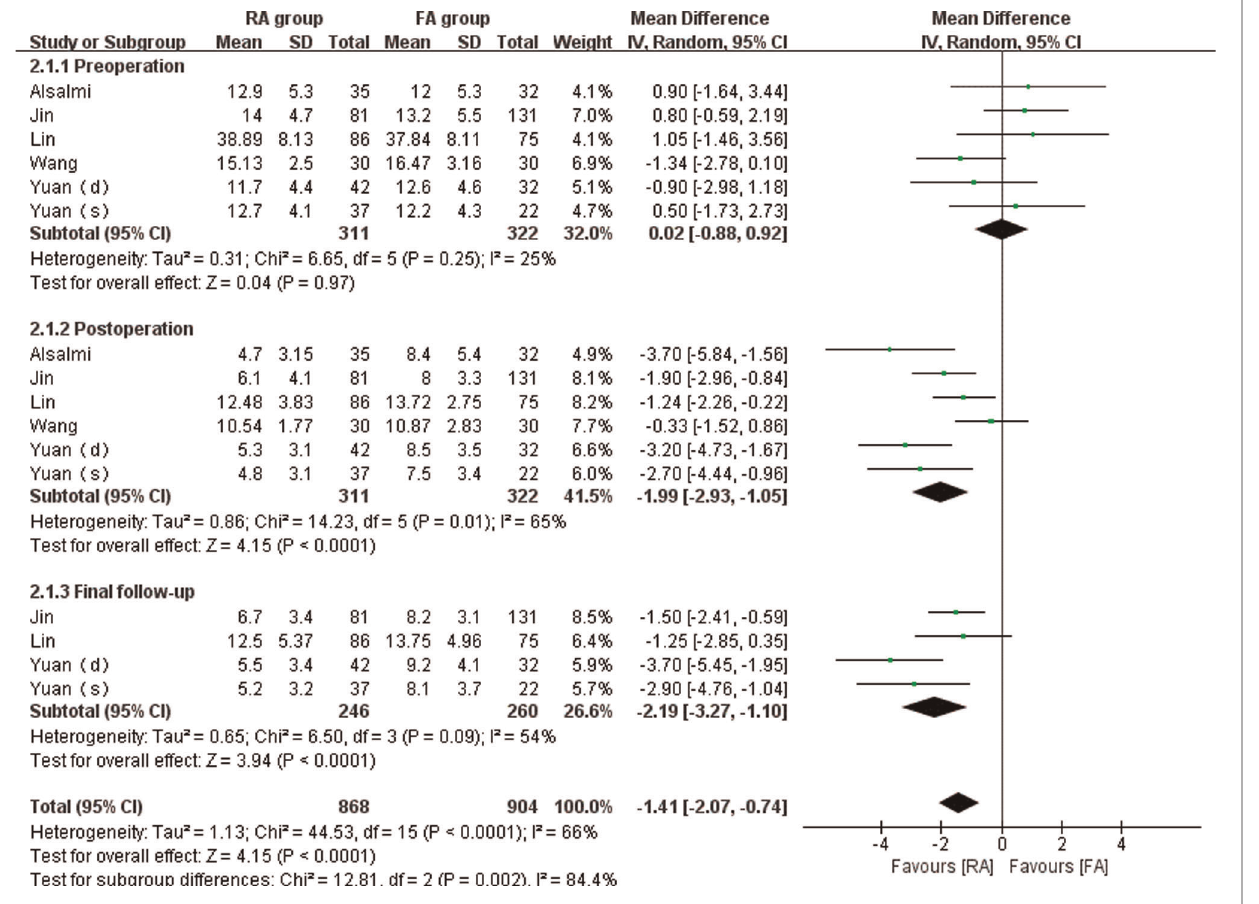
FIGURE 3 | Forest plot depicting WMDs of the vertebral kyphosis